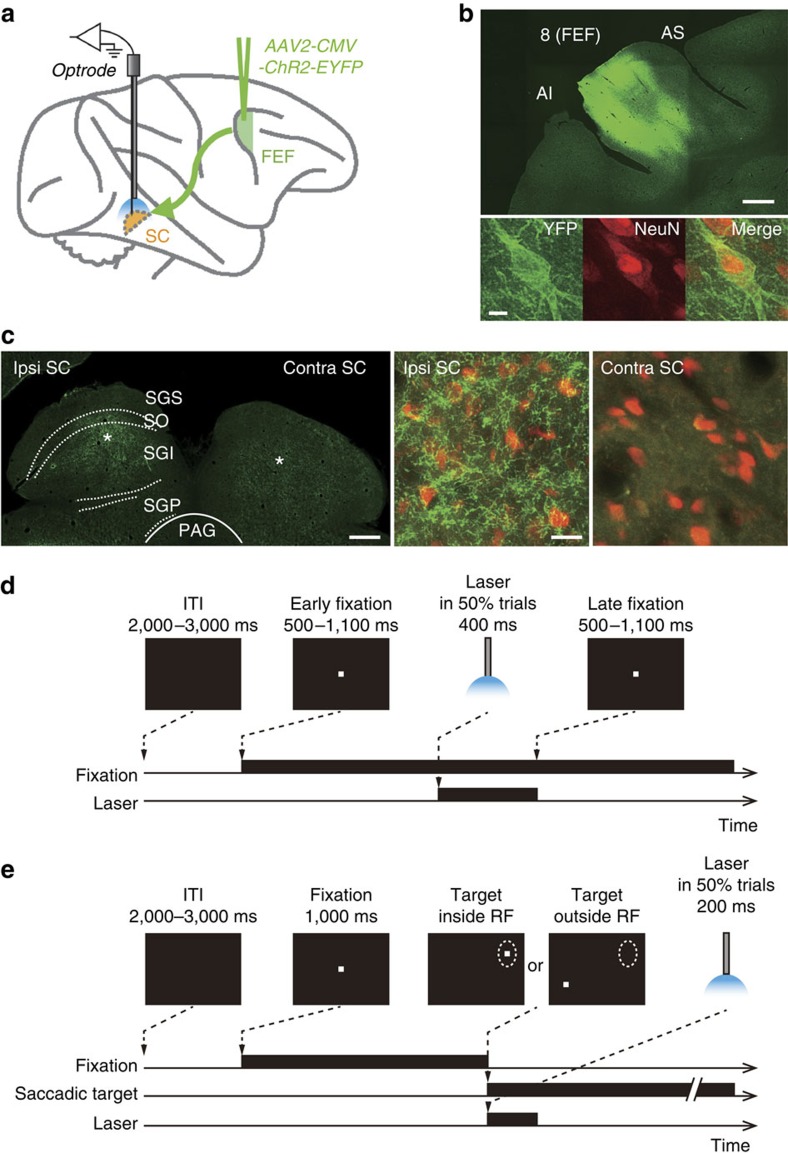
Experimental design and histological analysis.(a) Schema of experimental configuration. (b) ChR2-EYFP expression in the FEF. Top, wide-field fluorescent image of a coronal section through the FEF. Bottom, immunofluorescence of an FEF neuron example (left, YFP; middle, NeuN; right, YFP and NeuN). Scale bars, 2 mm for the top panel and 10 μm for the bottom panels. AI, inferior limb of the arcuate sulcus; AS, superior limb of the arcuate sulcus. (c) ChR2-EYFP expression in the SC. Left, wide-field immunofluorescent image of a coronal section through the SC. Middle and right, immunofluorescence of YFP-expressing axons in the ipsilateral and contralateral SC, respectively. NeuN-expressing SC neurons are shown in red. Asterisks in the left panel indicate the locations of the ipsilateral and contralateral images in the SC. Scale bars, 1 mm for the left panel and 20 μm for the middle and right panels. PAG, periaqueductal grey; SGI, stratum griseum intermediale; SGP, stratum griseum profundum; SGS, stratum griseum superficiale; SO, stratum opticum. (d) Fixation task. (e) Visually guided saccade task.